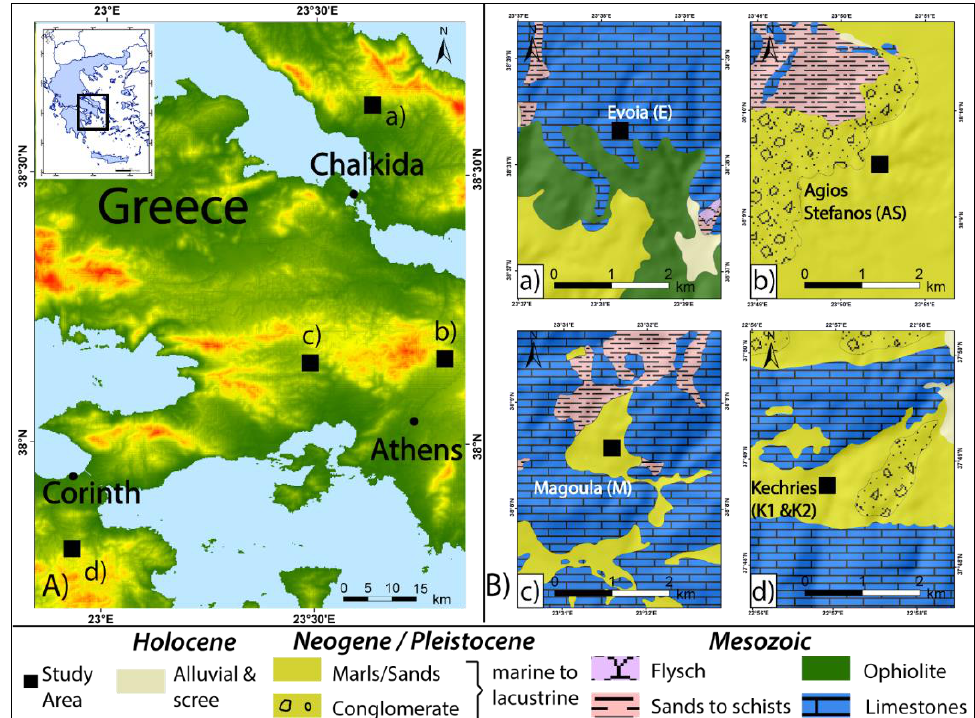
Figure 1. ( A ) DEM of the area showing the examined locations. ( B ) Simplified geology of the examined areas (modified after [57 – 60]).